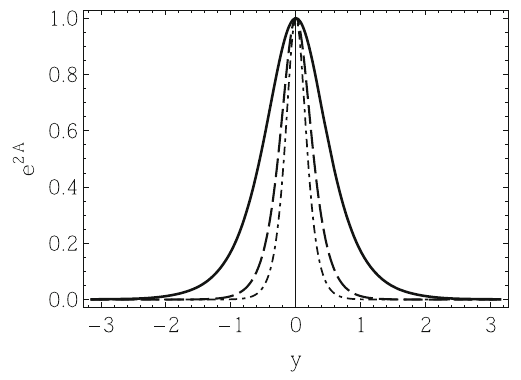
Fig. 2 Warp factor e 2 A given by Eq. (26) for a = 1 (solid line), a = 2 (dashed line) and a = 3 (dot-dashed line)